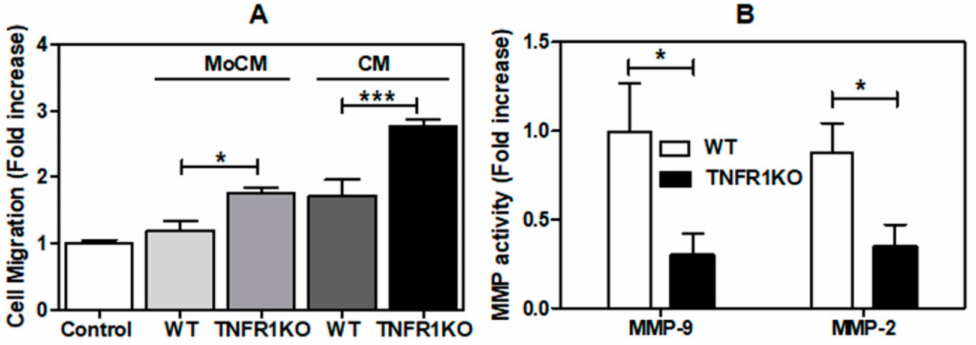
Figure 5. TNFR c ontrols migration and invasion of melanoma cells ( A ) Migration of B16.F1 cells induced by peritoneal macrophages CM (MoCM) and tumor CM (CM). The assay was performed in a modified Boyden Chamber ( B ) Zymography assay. Determination of metalloproteinase 2 (MMP-2) and 9 (MMP-9) present in tumor tissue of WT and TNFR1 KO mice obtained at day 19